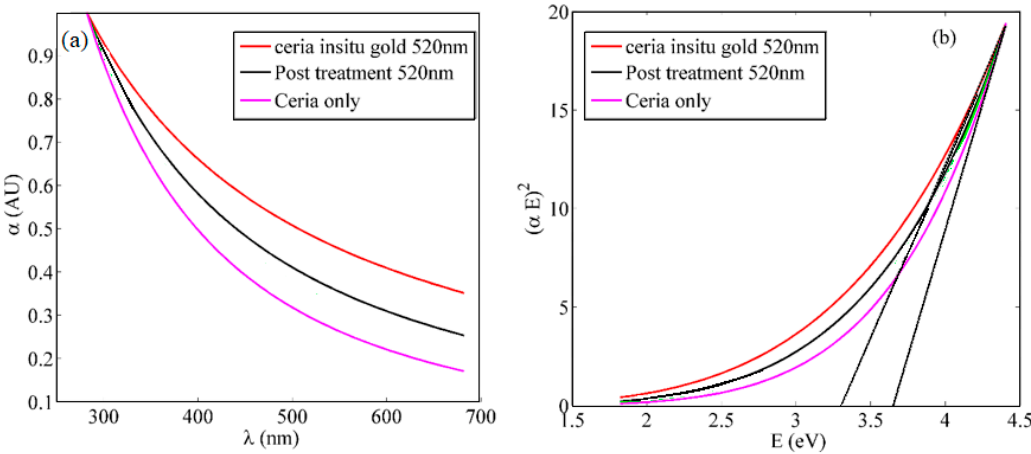
Figure 3. ( a ) Absorbance spectra, and ( b ) bandgap calculations of ceria NPs with and without added Au NPs. The added gold is in both cases of in-situ and post-synthesis.